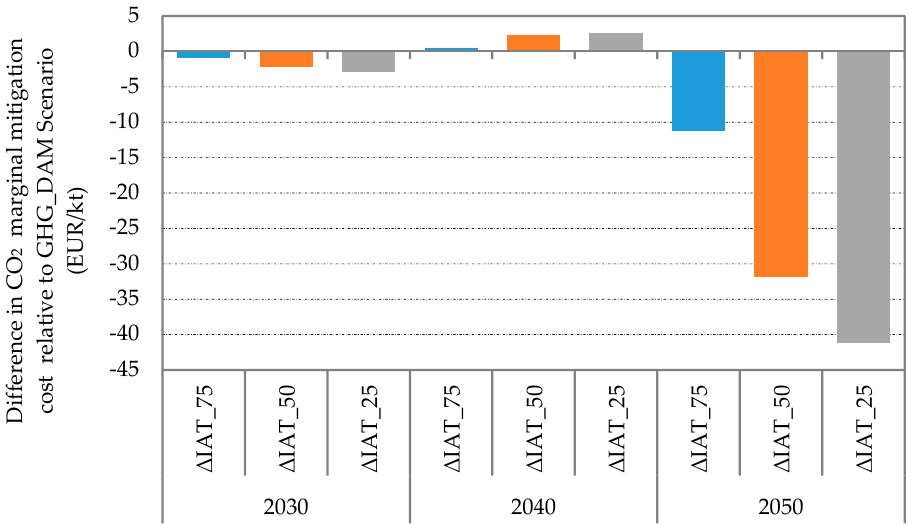
Figure 11. Difference in CO 2 marginal mitigation cost relative to GHG_DAM Scenario in the EU28 (€/kt).